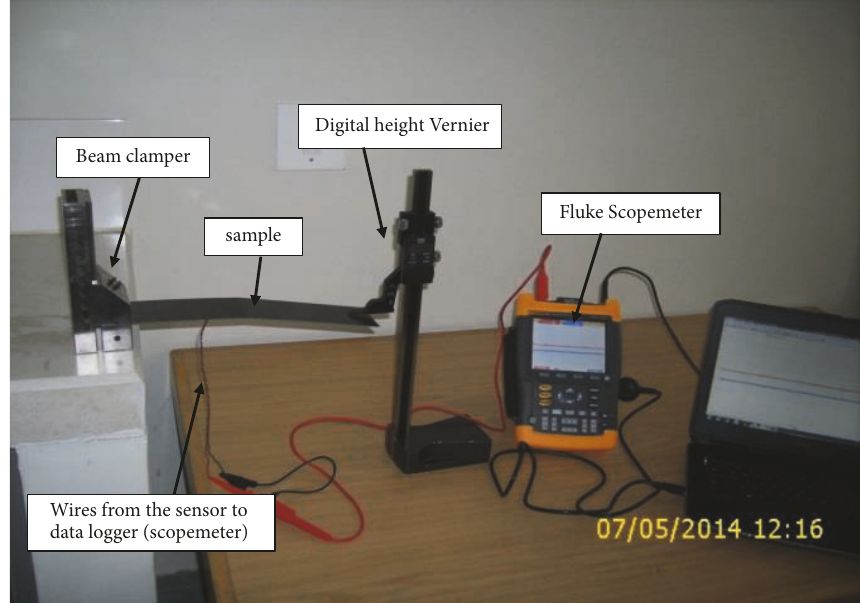
Figure 7: Deflection test setup.